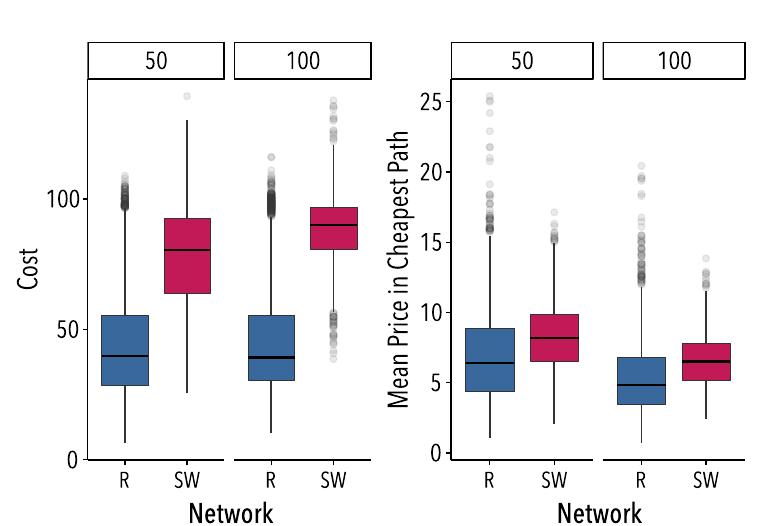
Figure 5. Numerical results of the model for networks with 50 and 100 nodes. Results shown are for 100 executions with 15 rounds for each network and source-destination pair, excluding the first round. Initial prices are bootstrapped from the experimental values. Values of σ and ρ are fixed and correspond to mean values of the experiment, respectively, 2.60 and 1.2. For similar analyses with random initial prices, see SI Fig. S7. Figure created using ggplot2 (v.3.2.1) 21 .